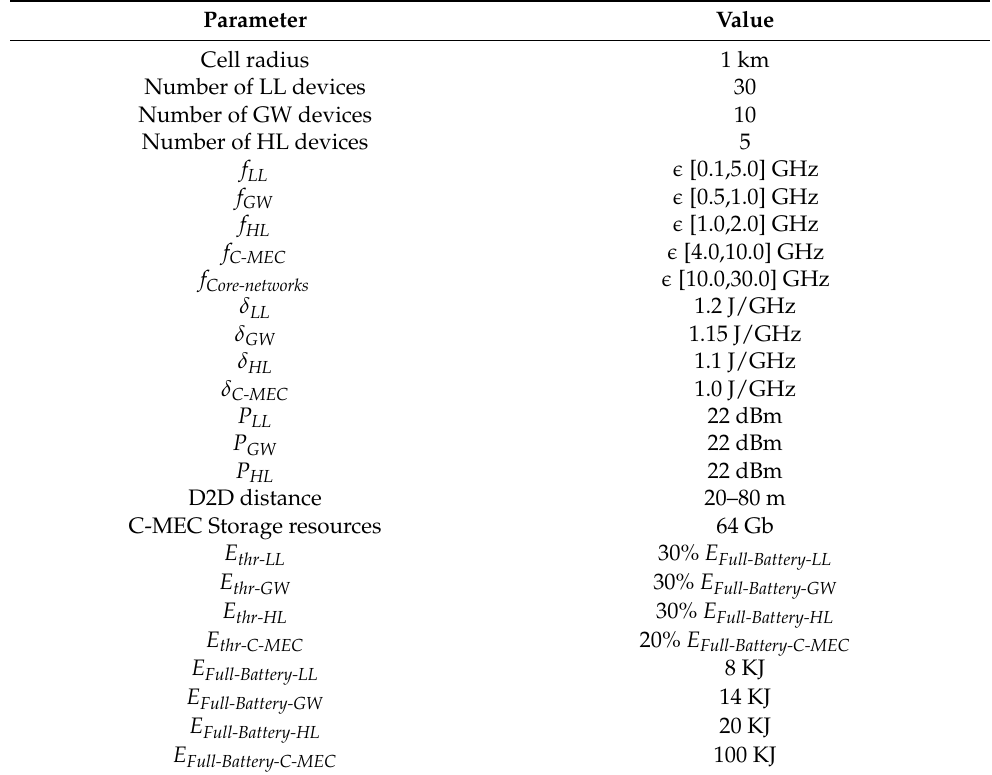
Table 4. Simulation parameters of the radio access network (RAN) of a cellular network.